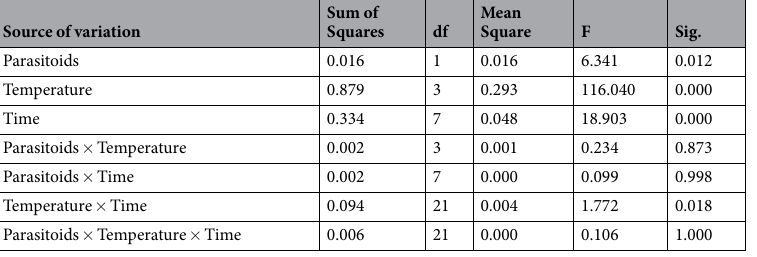
Table 3. Analysis of variance of the ant tending level with parasitoid, temperature, and investigation